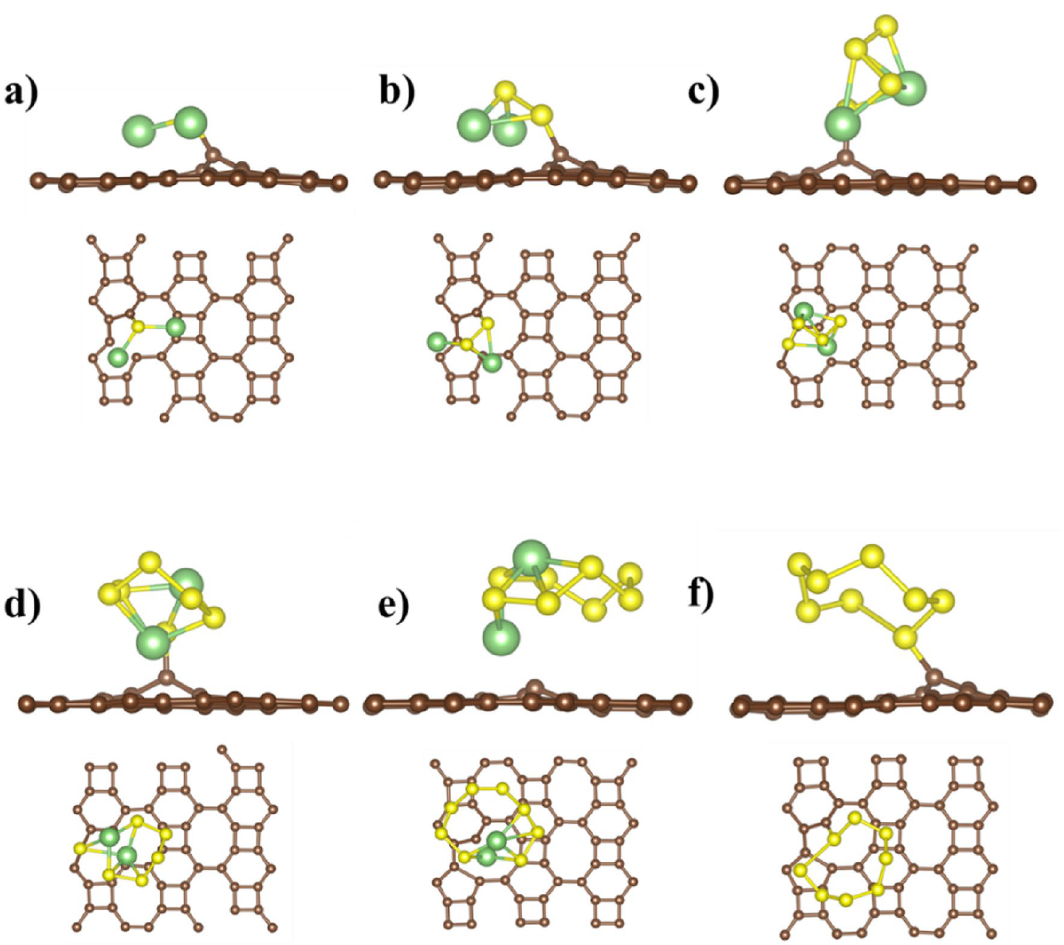
Figure 4. Ground state configuration of defective BPN sheet (D2) adsorbed with ( a ) Li 2 S ( b ) Li 2 S 2 ( c ) Li 2 S 4 ( d ) Li